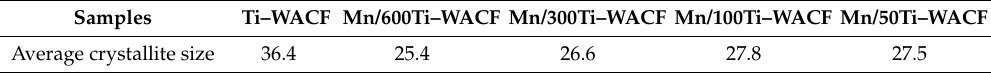
Table 1. Average crystallite size of nano-TiO 2 doped with different Mn doping concentrations.